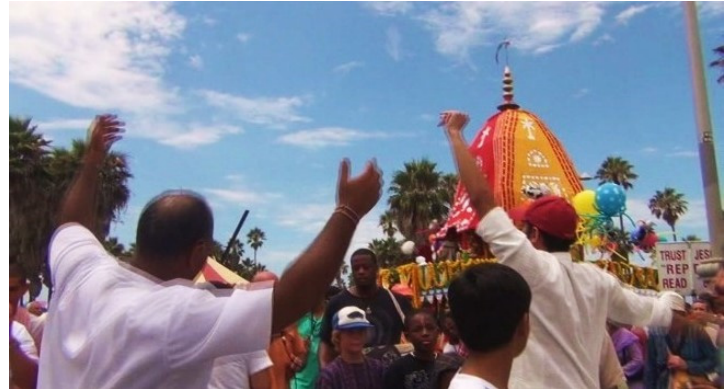
Figure 1. Dancing before Jagannath’s cart.